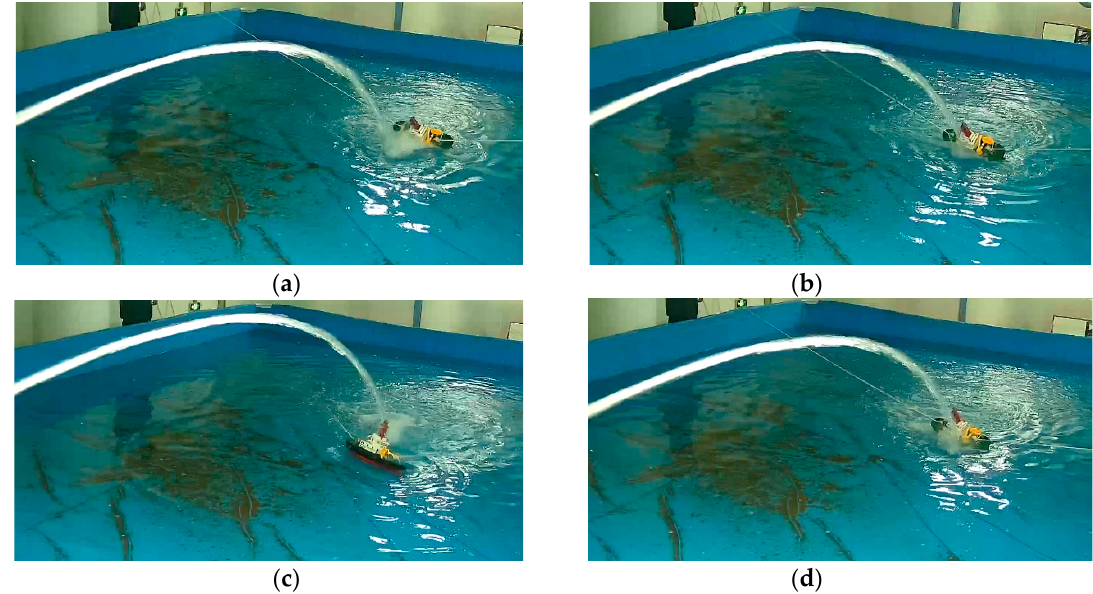
Figure 9. Actual platform test results. ( a ) The jet falls in front of the target; ( b ) Shoot the target after adjustment; ( c ) The jet falls behind the target; ( d ) Shoot the target after adjustment. Table 5. Number of iterations and required time at different distances.